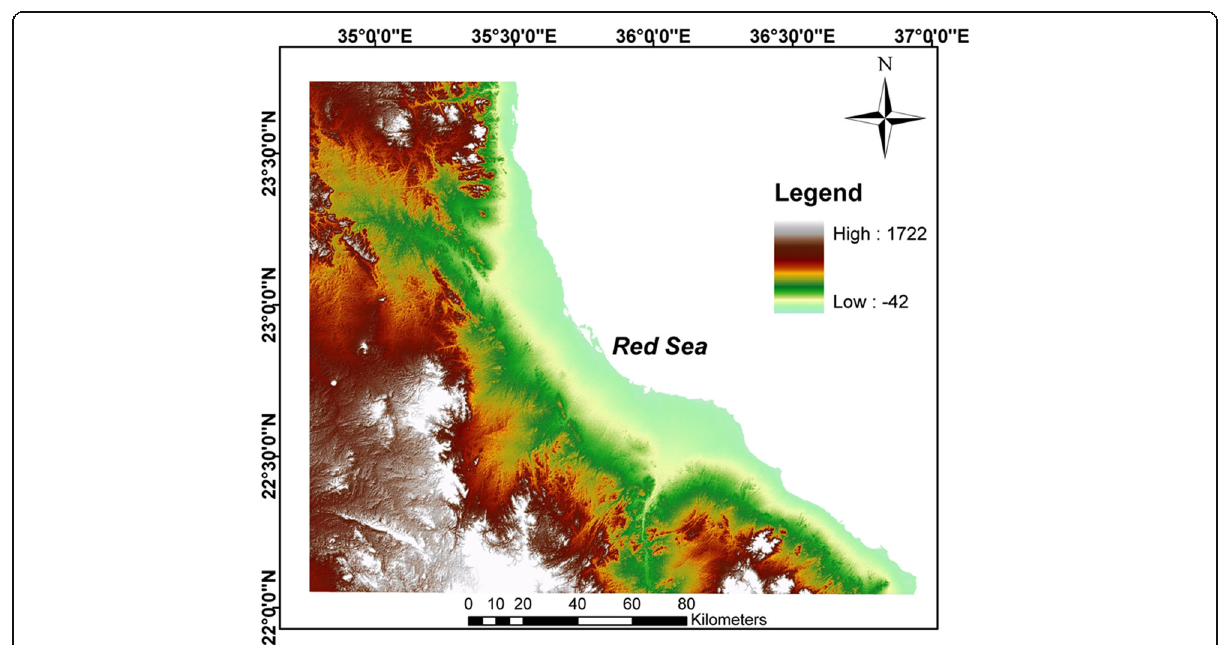
Fig. 8 Digital elevation model (DEM) of the study area (SRTM, 30